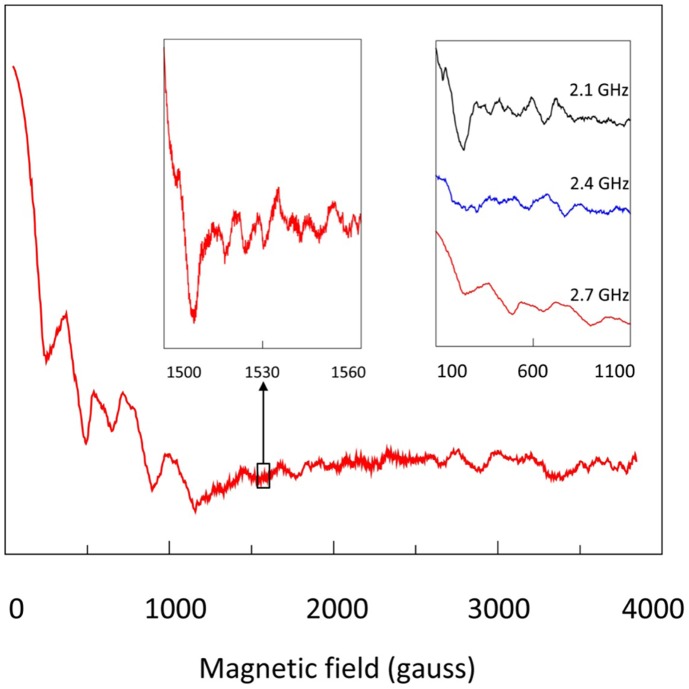
High-resolution transmission EPR spectra of 0.2 mol% Mn(II) in ZnSO4⋅H2O.The 220 cm cell held circa 5 g of powder of which circa 10 mg originated from MnSO4⋅H2O. Each trace is the differentiated average of circa 2500 forward scans of 100 s. The main trace was taken at 2.7 GHz; the left insert is a blow-up of a small section to illustrate detection of fine spectral details. The right insert shows very strong frequency dependence of the low-field part of the spectrum. Notethat these spectra are sums of spectra for all possible orientations of B’ versus B.